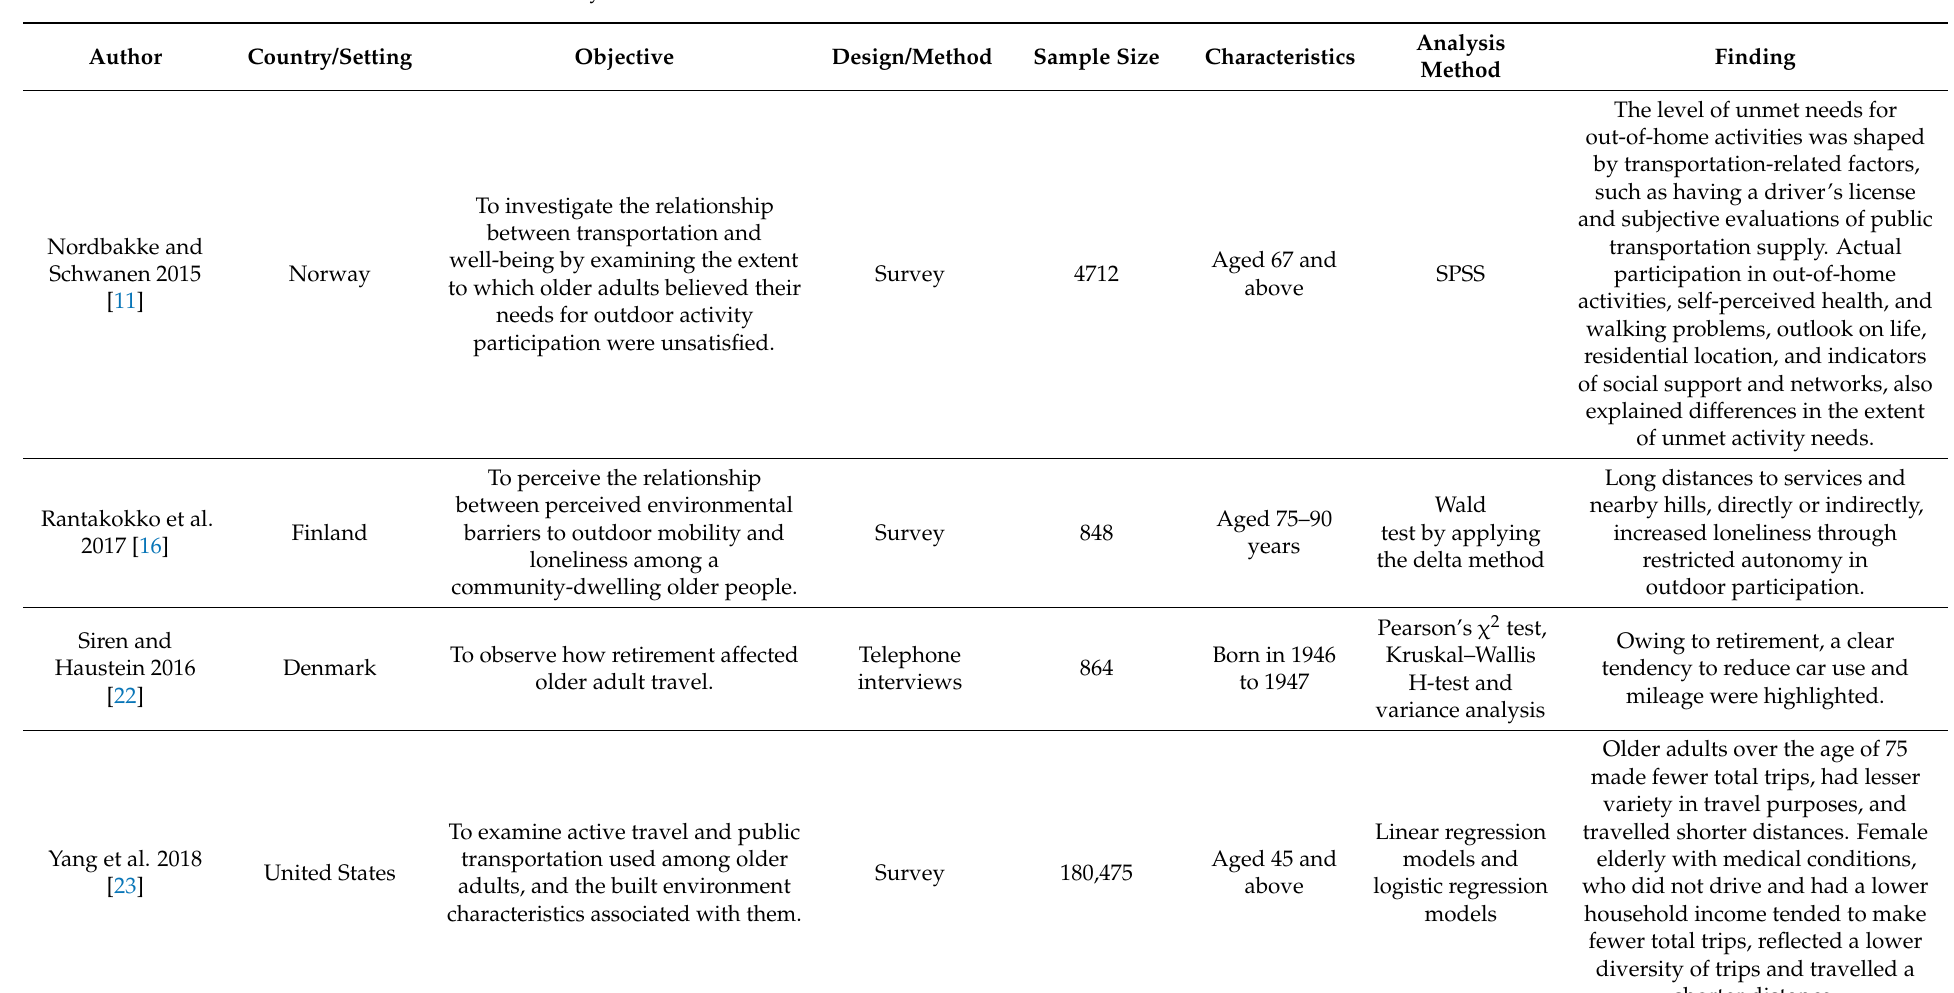
Table 2. Article